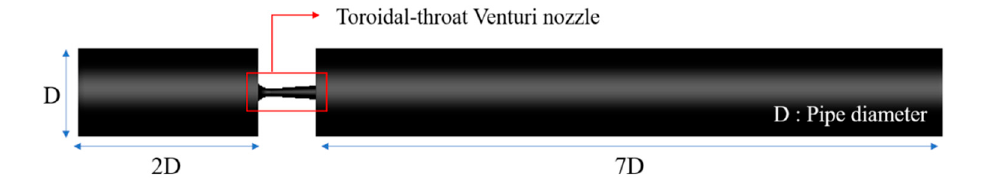
Figure 8. Three-dimensional geometry of pipe with critical nozzle.